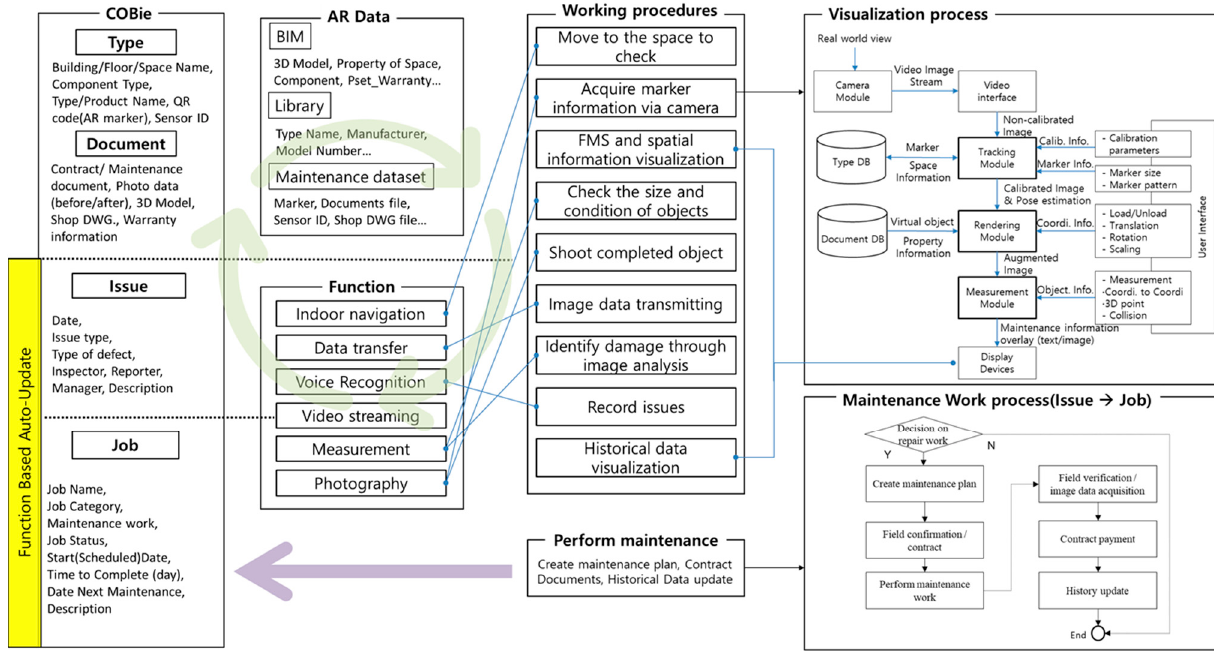
Figure 12. Information flowchart of AR-based smart FMSs.